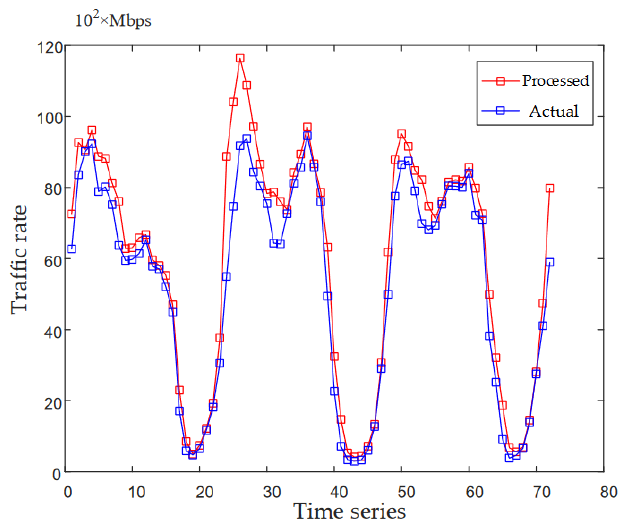
Figure 6. Traffic comparison chart.